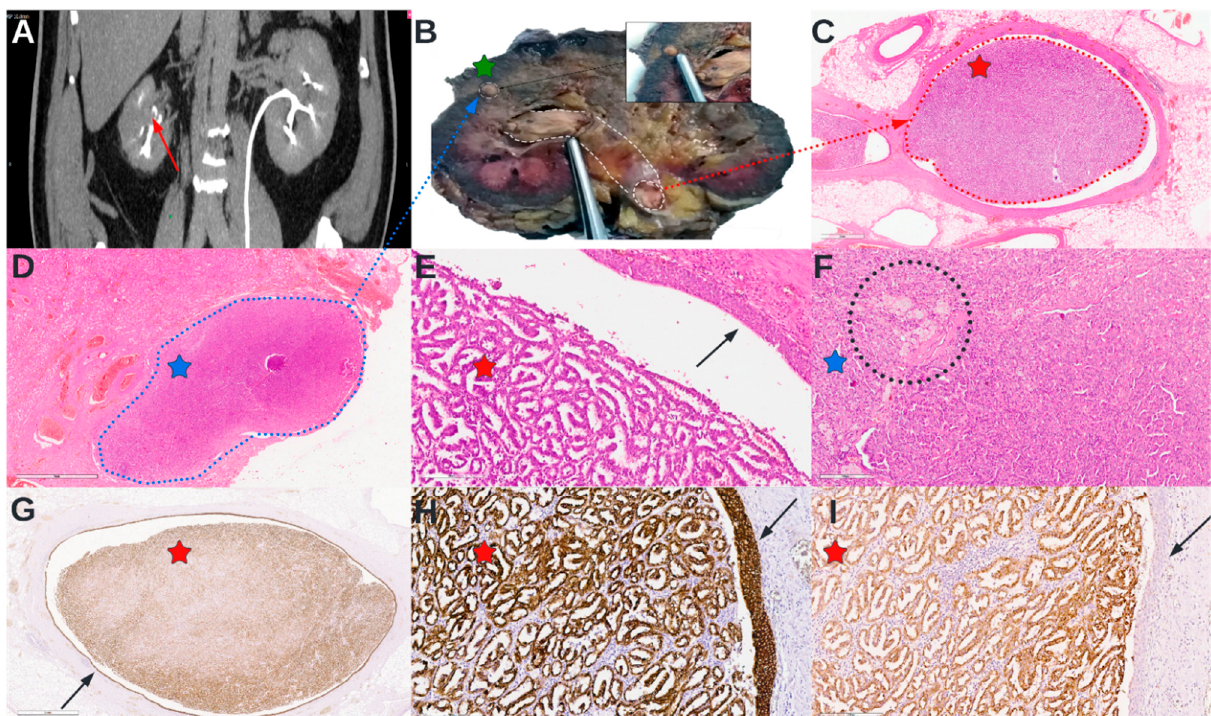
Figure 1. A selected panel of images containing representative snapshots of the tumor from CT to IHC. ( A ) Selected section from the contrast-enhanced CT of the abdomen that showed an hypo-enhancing nodular lesion in the right kidney that measured approximately 38 × 26 × 21 mm (green star on the bivalved nephrectomy surgical specimen while grossing); delayed scan of the lesion that showed the apparent invasion of the renal pelvis (red arrow); ( B ) Pathological grossing of the nephrectomy surgical specimen, bivalved section, that shows a nodular lesion of approximately 3 × 2 × 2 cm located medially, near the corticomedullary boundary; further sections revealed that the nodular lesion was in communication with the cordon-like tumor that shows an intra-pyelocalyceal (non-invasive and compressive) growth pattern (demarcated with dashed white lines), extending all the way to the opening of the proximal ureter; ( C ) H&E section from the renal pelvis showing the cordon-like (demarcated with dashed red lines), red dashed arrow indicates the section origin; ( D ) H&E section from the nodular lesion (demarcated with dashed blue lines), blue dashed arrow indicates the section origin; ( E ) H&E section from the renal pelvis showing the tumor composed of tubulo-papillary structures, the red star indicates the section corresponding to the red star on image ( C ); the black arrow indicates normal urothelium; ( F ) H&E section with higher magnification of the nodular lesion showing compact tubulo-papillary structures lined single layer small cuboidal cells with inconspicuous nucleoli, black dashed circle indicates foamy macrophages; blue star indicates the section corresponding to the blue star on image ( D ); ( G ) IHC for CK7 showing intense and diffusely positive stain both in the tumor and in the urothelium indicated by the black arrow; ( H ) Higher magnification of IHC for CK7 showed in image ( G ), the red star indicates the section corresponding to the red star on image ( G ); the black arrow indicates the urothelium positive for CK7; ( I ) IHC for AMACR showing positive granular stained tumor cells, with negatively stained urothelium marked by the black arrow; the red star indicates the section corresponding to the red star on image ( H ).